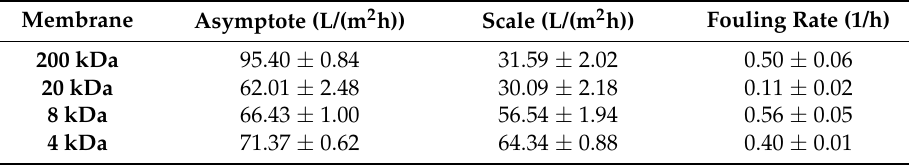
Figure 9. Exponential fouling model on 8 kDa and 4 kDa in membrane filtration experiment at 24.13 bar. Table 5. Exponential fouling model parameters (Mean ± standard error).